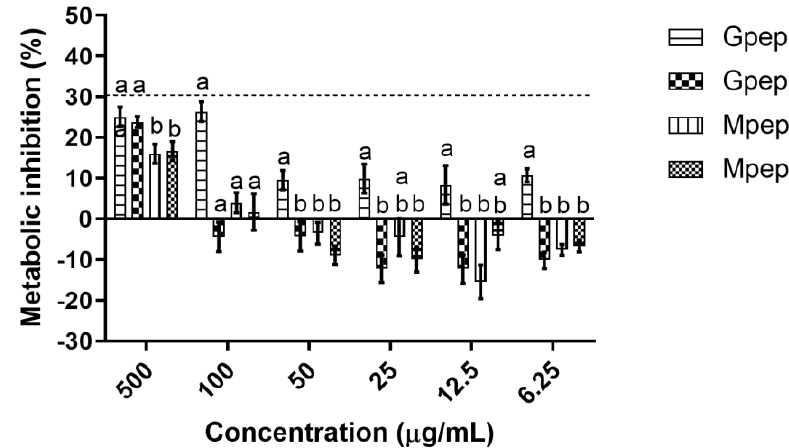
Figure 3. Peptide fractions ’ impact upon HDFa cells metabolic activity. Different letters represent the statistically significant ( p < 0.05) differences found between the four samples tested at each concentration assayed. The dotted line represents the 30% cytotoxicity limit as defined by the ISO 10993-5:2.